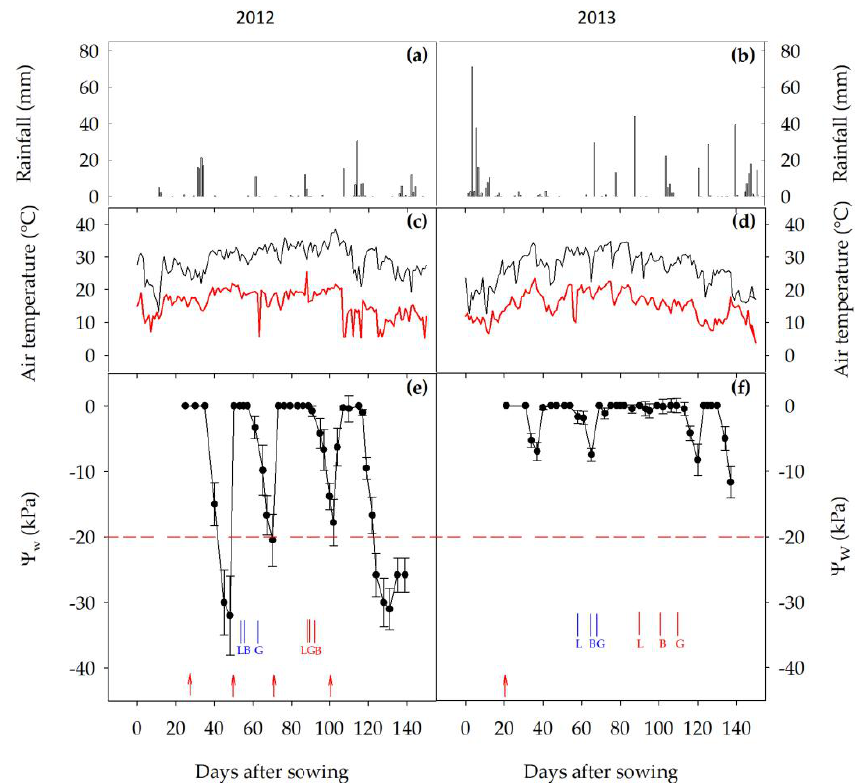
Figure 1. Values of rainfall ( a, b ), air temperature ( c, d ), and soil water potential (Ψ w ; e, f ) in the two growing seasons 2012 ( a, c, e ) and 2013 ( b, d, f ); c and d: Black lines: Maximum values; red lines: Minimum values; e and f: Red arrows indicate field flooding in the AWD field trials; blue vertical lines indicate the panicle initiation day of ‘Baldo’ (B), ‘Gladio’ (G), and ‘Loto’ (L); red vertical lines indicate the flowering days of ‘Baldo’ (B), ‘Gladio’ (G), and ‘Loto’ (L). Th e red dotted horizontal line indicates the – 20 kPa value usually considered in the literature as a threshold for reflooding [9]. Ψ w values are the means ± SD of six measurements.